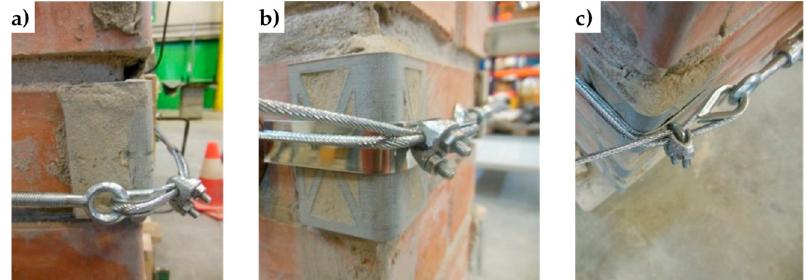
Figure 55. Rounded angles of the second combined technique: ( a ) indentation marks on a rounded angle after pre-tensioning and removal of the tying system, in the absence of a protective element between the steel wire rope and the PLA element. ( b ) Use of a steel ribbon to protect a PLA rounded angle (front view). ( c ) Use of a steel ribbon to protect a PLA rounded angle (top view).